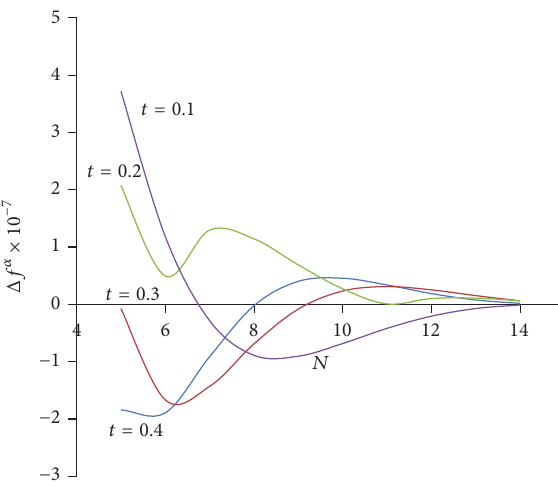
Figure 1: The convergence of series in (7) for 𝛼 = 0 with different values of parameter 𝑡 for noninteger SF three-center ⃗𝑅 , ⃗𝑅 ) in atomic units nuclear attraction integrals 𝐼 1.300,1.100 (𝜁, 𝜁 󸀠 , 𝑐𝑎 𝑎𝑏 (a.u.) as a function of the indices 𝑁 ( 𝑅 𝑎𝑐 = 1.8 , 𝜃 𝑎𝑐 = 30 , 𝜙 𝑎𝑐 = 60 , 𝑅 = 1.1 , 𝜃 = 60 , 𝜙 = 60 , and 𝛼 = 0 𝑎𝑏 𝑎𝑏 𝑎𝑏